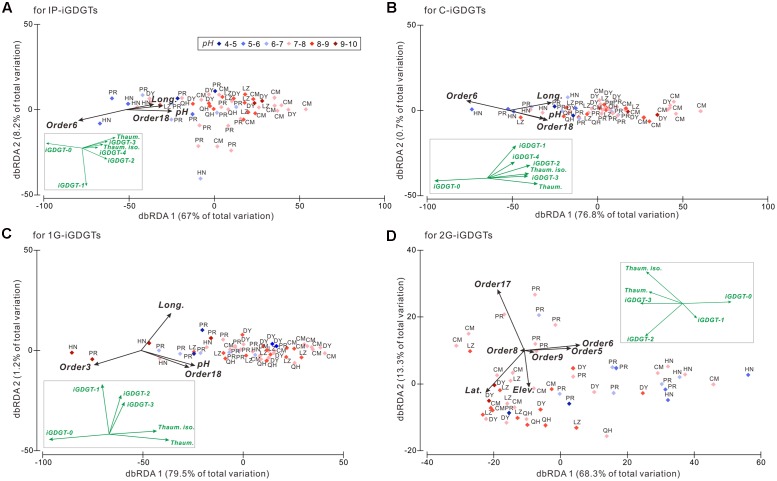
The distance based redundancy analysis (dbRDA) plot showing the isoprenoid glycerol dibiphytanyl glycerol tetraether (iGDGT) distributions against the geographic and environmental parameters and the archaeal community at the order level among samples in the IP- (A), C- (B), 1G- (C), and 2G-iGDGT (D) fractions. The black vectors represent predictor variables including the geographic and environmental parameters and the archaeal community DNA composition. Only the significant predictor variables (P < 0.05) are shown in the plot. The iGDGT patterns are shown as the green vectors and inserted in each panel for comparison with the predictor variables. Order3, Methanobacteriales; Order5, Methanocellales; Order6, Methanomicrobiales; Order8, Thermoplasmatales; Order9, Undefined order in Thaumarchaeota; Order17, Group I.1b A; Order18, Group I.1b B. Both Order17 and 18 were assigned to Soil Crenarchaeotic Group (SCG) in the processing of the 454 tag sequences using SILVA 115 database. Soil Crenarchaeotic Group is also known as Group I.1b and thus we named Order17 as Group I.1b A and Order18 as Group I.1b B.